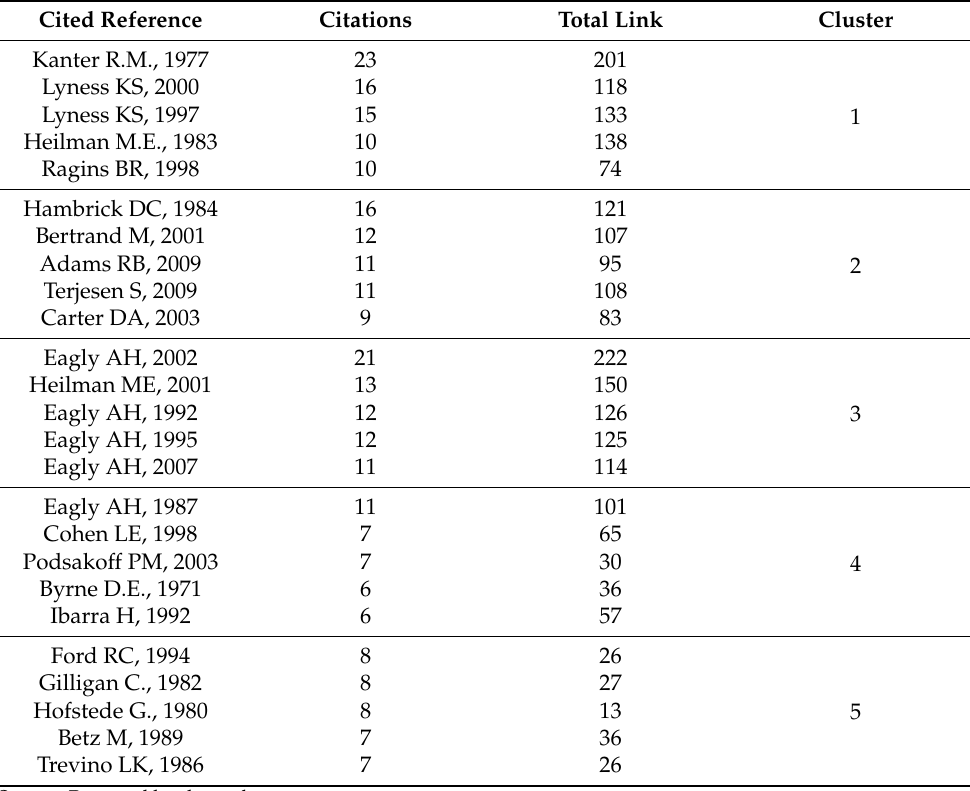
Table 8. Classification of the most cited works in each cluster.